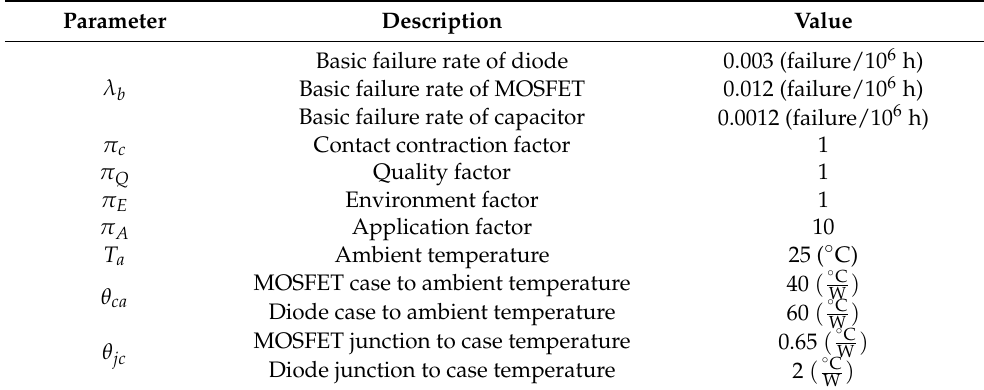
Table 5. Numerical Values Necessary for Calculation of Effective Parameters on Failure